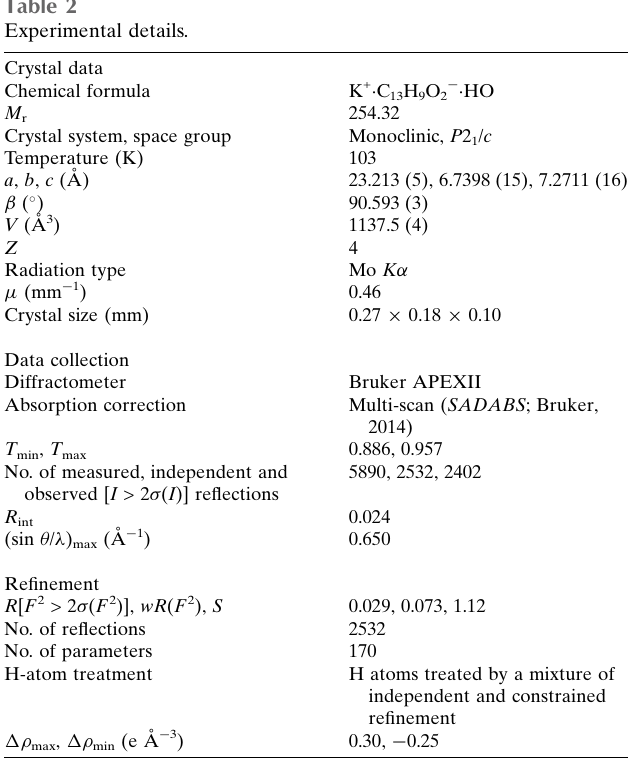
Table 2 Experimental details.